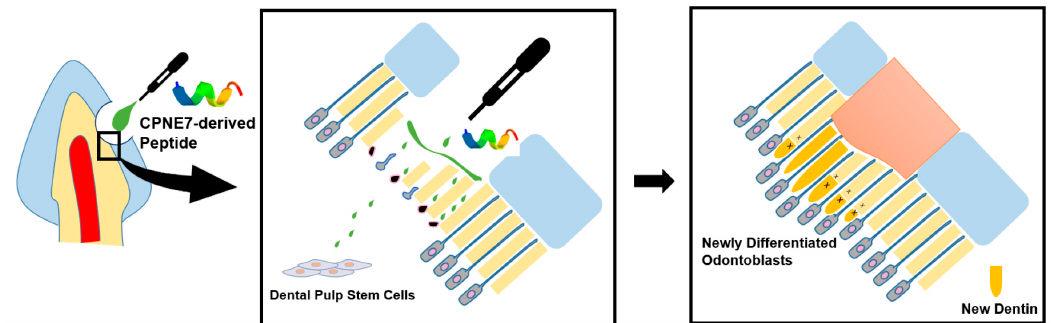
Figure 6. Schematic illustration of CPNE7 acting in two different ways to regenerate tubular dentin. In cases of a mild stimulus followed by shallow dentinal defects, treatment of CPNE7 leads to the